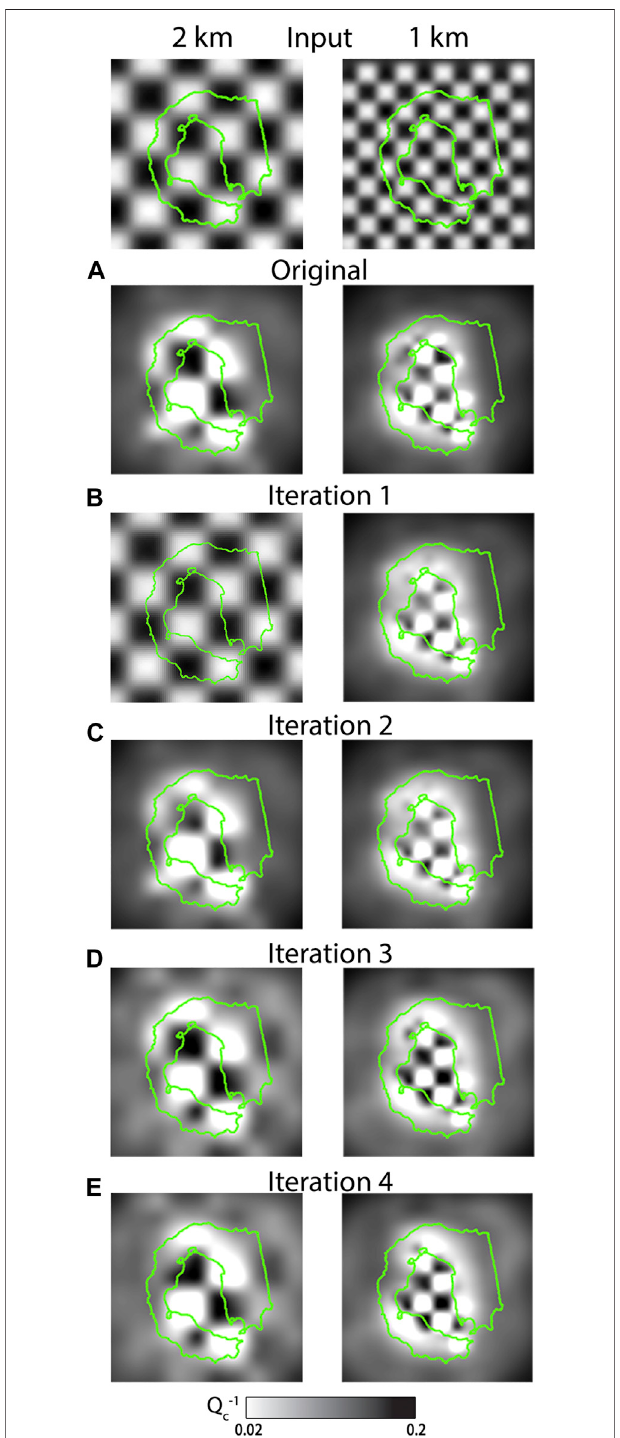
FIGURE 6 | Chequerboard test input and output maps related to the datasets obtained after each iteration. The colorbar shows the variations of ( Qc − 1